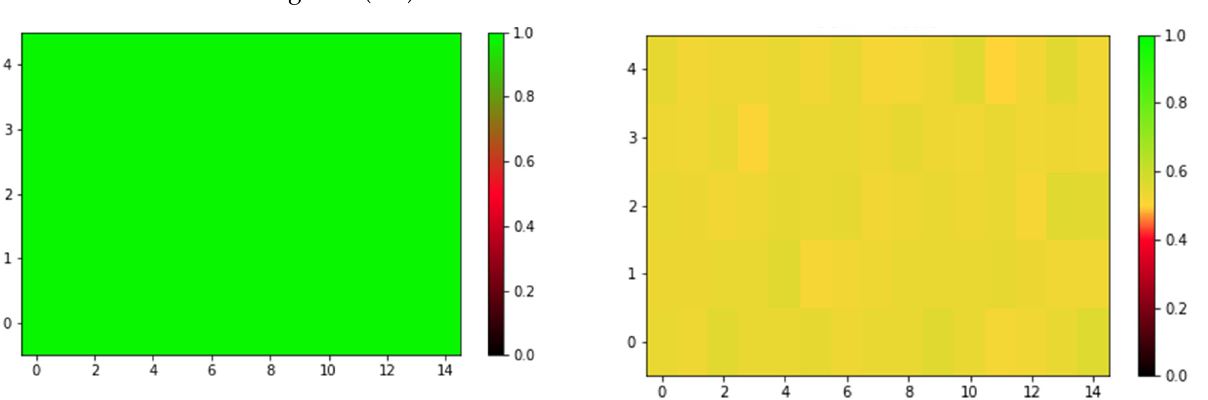
Figure 7. SOW estimation of each of the battery modules in the battery system.